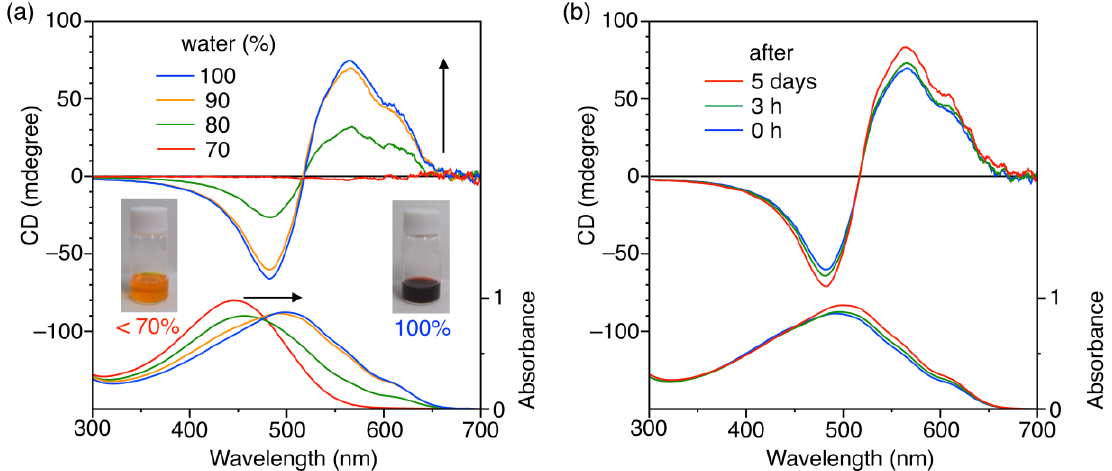
Figure 2. Circular dichroism (CD) and absorption spectra of ( S )-poly- 1a - b -poly- 3 in THF/water at rt: ( a ) effect of THF in water; ( b ) time-dependent change in water. [( S )-poly- 1a - b -poly- 3 ] = 0.5 mg/mL.